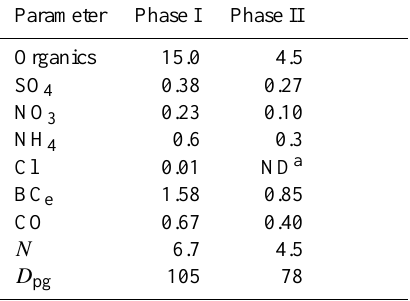
Table 1. Mean values observed during SAMBBA separated be- tween Phase I (13 to 22 September 2012) and Phase II (22 to 30 September 2012). Non-refractory and BC e concentrations are given in µgm − 3 . CO is given in ppmv, aerosol number concentration ( N ) in 1000 particles cm − 3 , and aerosol mean diameter ( D pg ) in